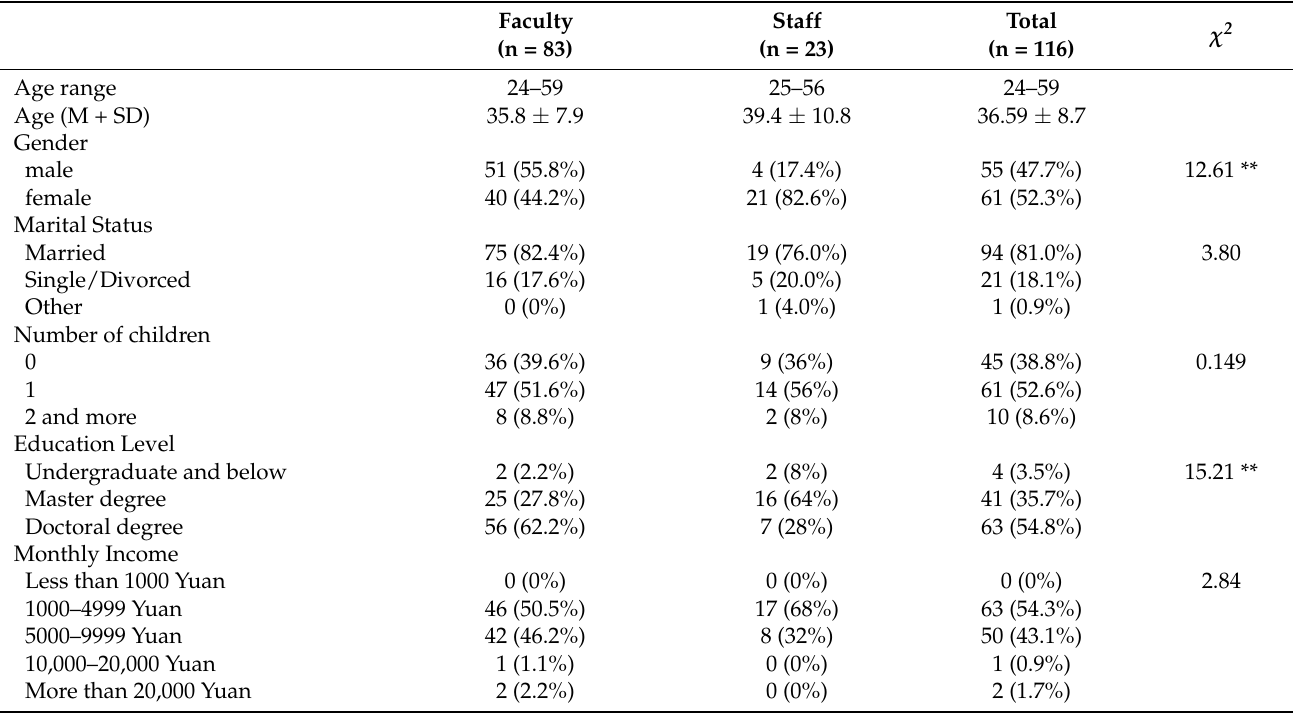
Table 1. Characteristics of participants (n = 116).